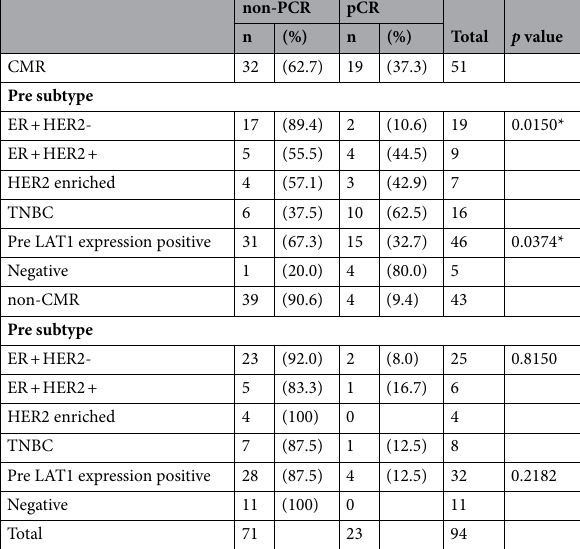
Table 3. Comparison of treatment response assessments between pathologic response and CMR(PERCIST) in breast cancer patients with neoadjuvant chemotherapy (n = 94). CMR, complete metabolic response; PERCIST, Positron Emission Tomography Response Evaluation Criteria in Solid Tumors; ER, estrogen receptor; PR, progesterone receptor; HER2, human epidermal growth factor receptor-2; TNBC, triple negative breast cancer; LATl, L-type amino acid transporter-1, SLC7A5; Pathological complete response: